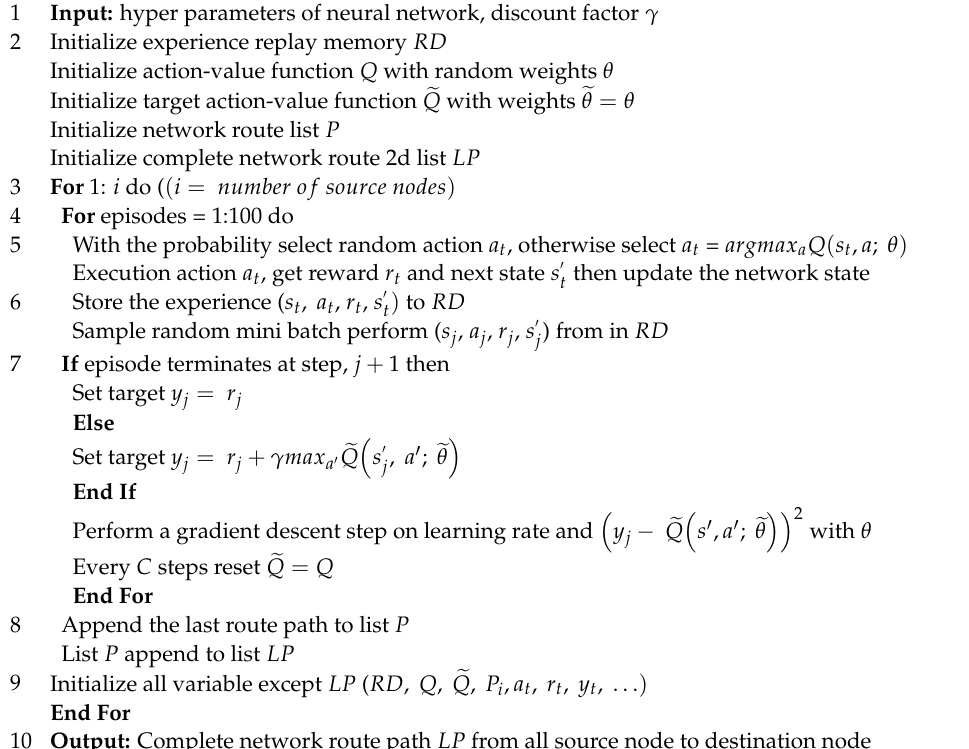
Algorithm 1 DQN-based network routing in Erasure Coding network